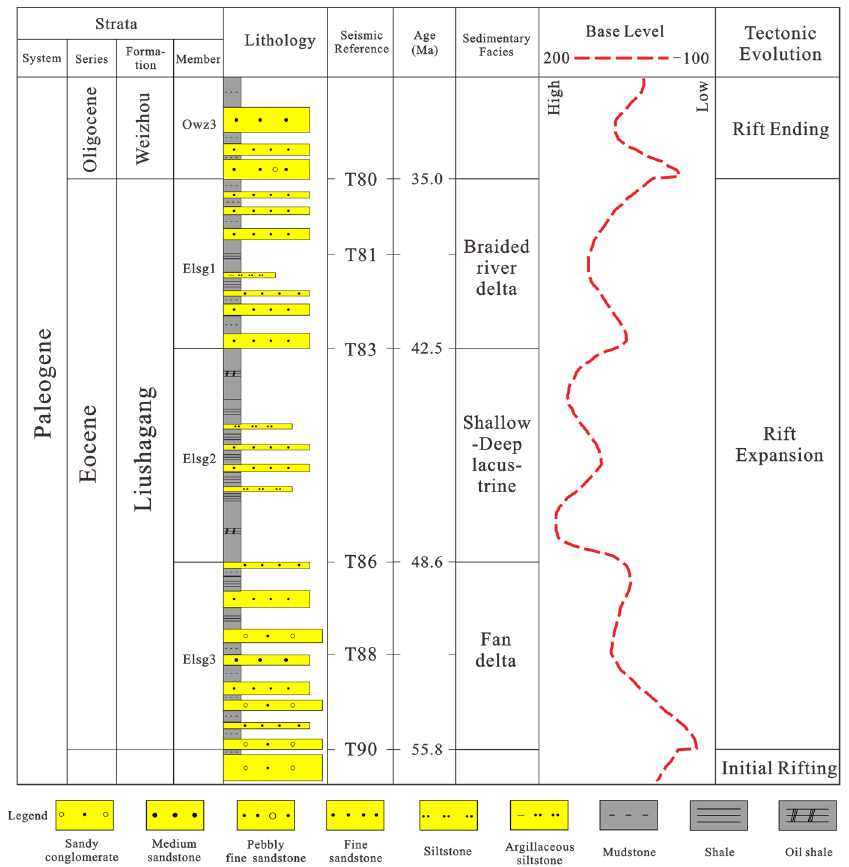
Figure 2. Stratigraphic evolution histogram of the Weixinan Sag, Beibuwan Basin.